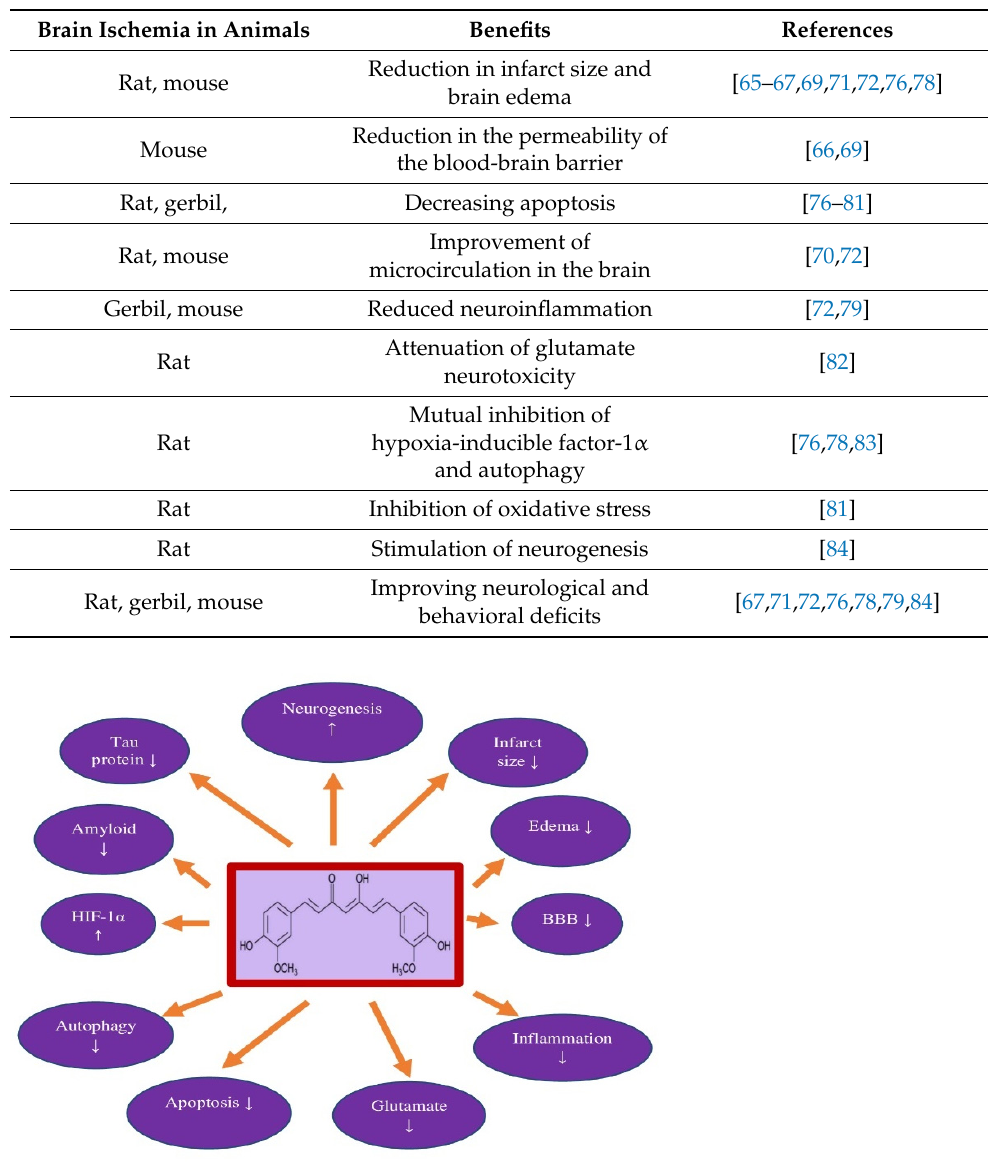
Figure 2. Protective influence of curcumin on post-ischemic brain neurodegeneration phenomena. In a rectangle-structure of curcumin, ↓ —decrease, ↑ —increase, BBB-blood brain barrier, HIF-1 α -hypoxia-inducible factor-1 α .